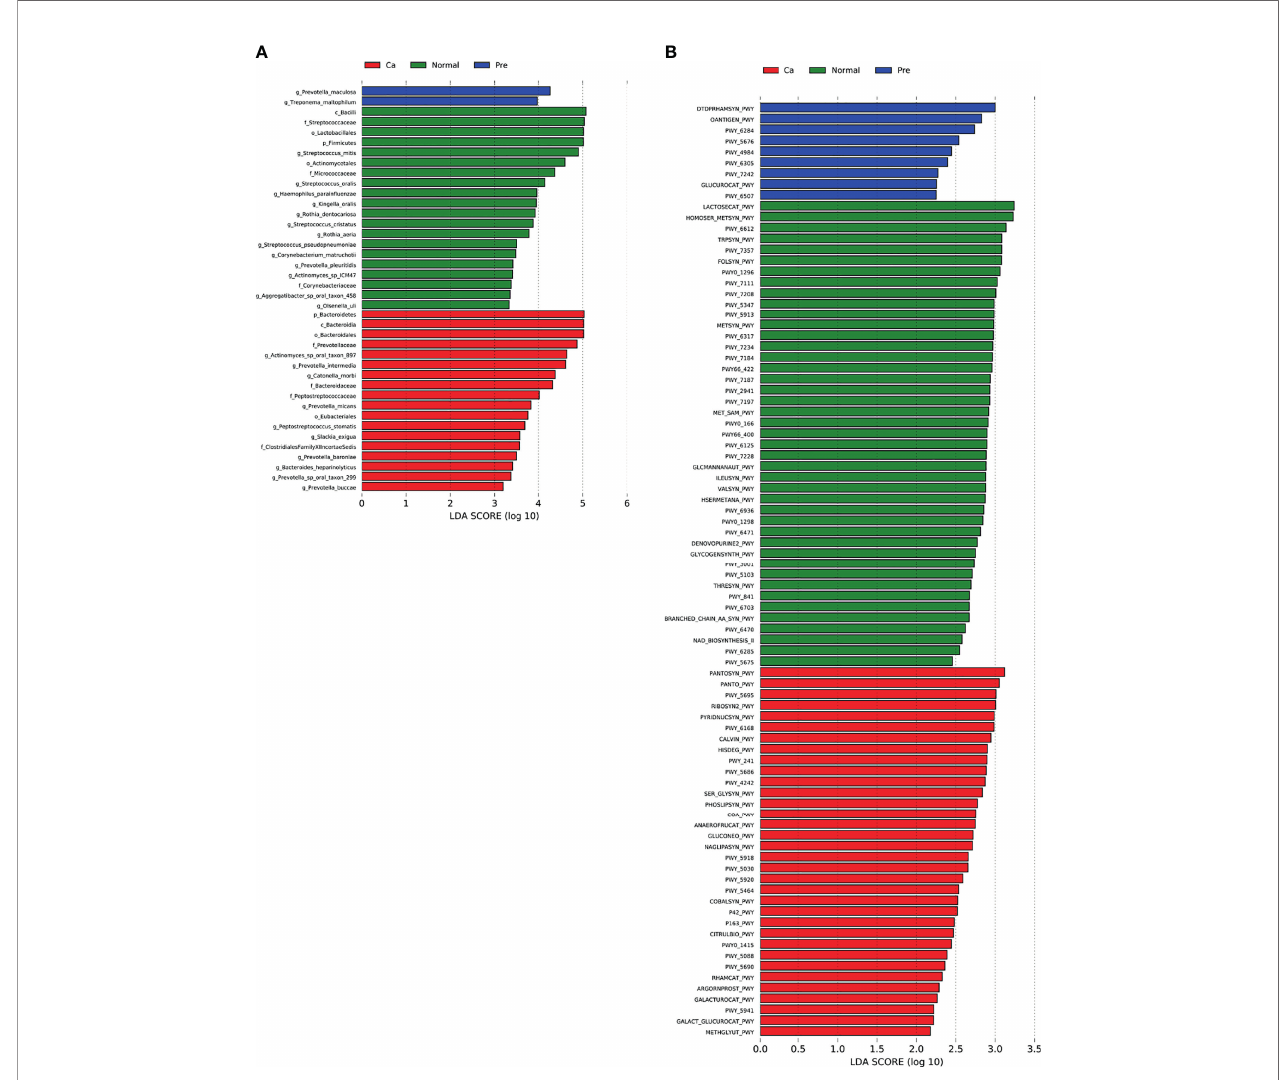
FIGURE 6 | Analysis of markers between samples; green represents the normal control group, red represents the oral cancer group, and blue represents the precancerous lesion group. lgLDA >2 is signi fi cant. (A) The LEfSe algorithm was used to analyze the bacteria in different groups. (B) The LEfSe algorithm was used to analyze the function of bacteria in different